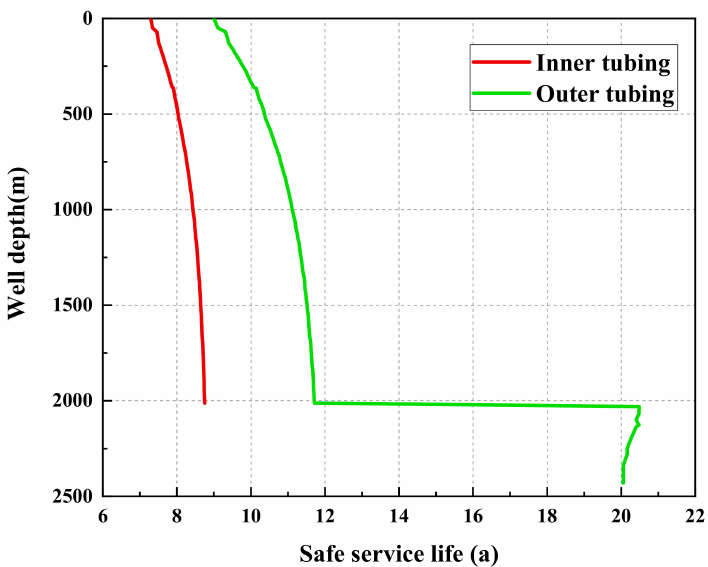
Figure 14. Corrosion life distribution of the